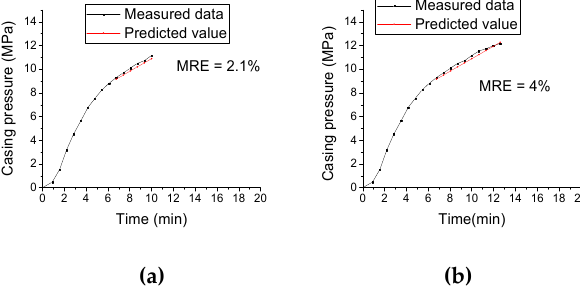
Figure 17. Measured data and predicted value of casing pressure vs. time in different periods: ( a ) prediction period 6.75–10 min and ( b ) prediction period 6.75–12.6 min.